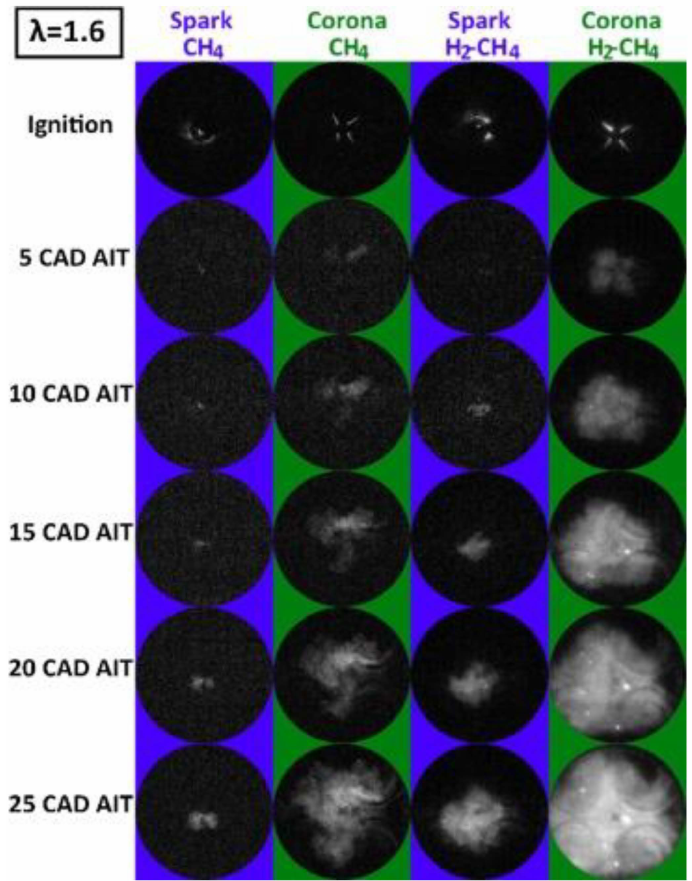
Figure 9. Flame fronts evolution; λ = 1.6. Images are cropped in correspondence to the optical limit (30 mm radius) [40].